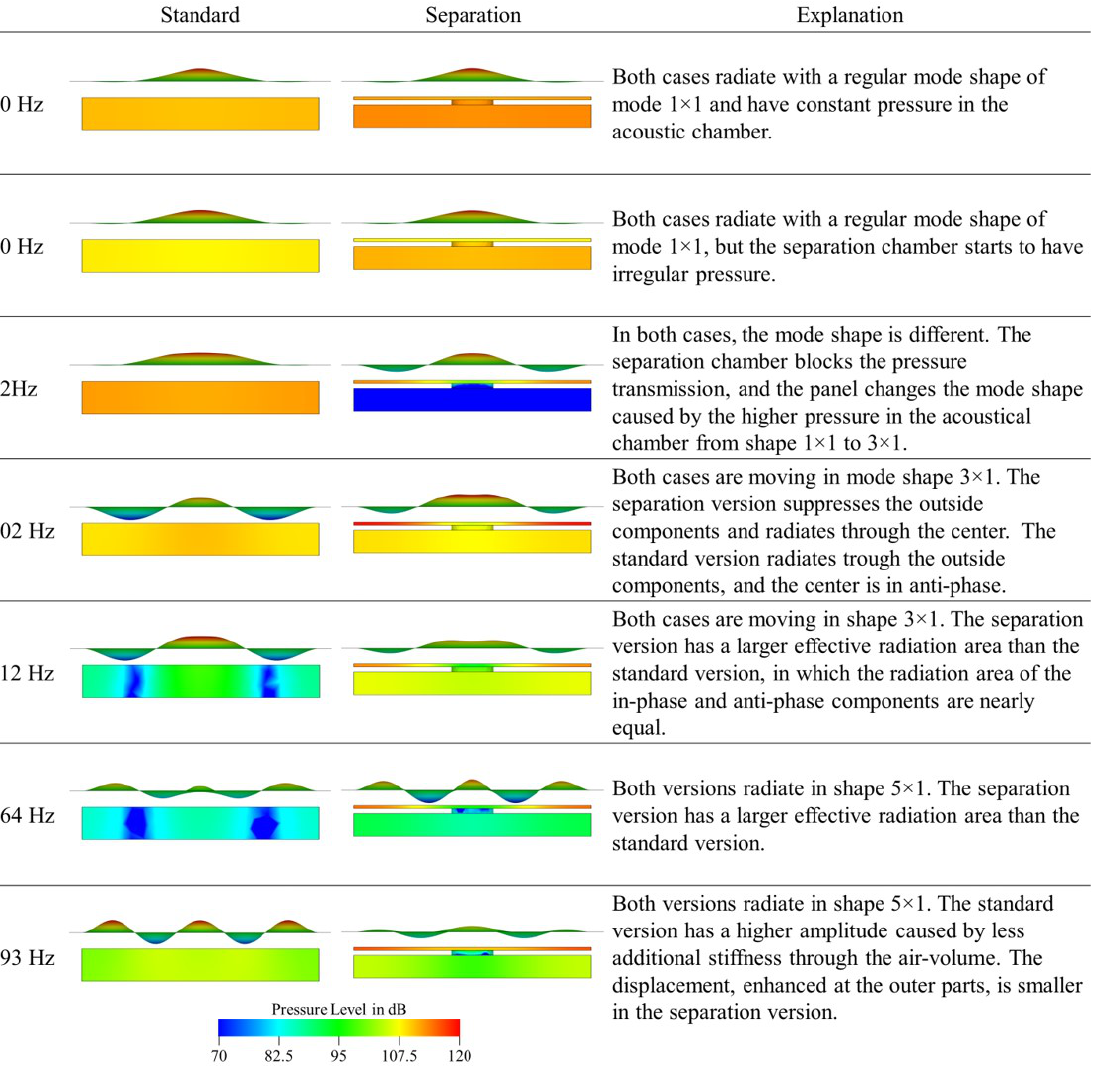
Figure 11. Visualization of the displacement and pressure in the acoustic chamber of the standard against the separation version. The displacement scale is adjusted for every frequency, but both versions are scaled to the same range. The pressure scale is in dB and the frequencies are similar for all